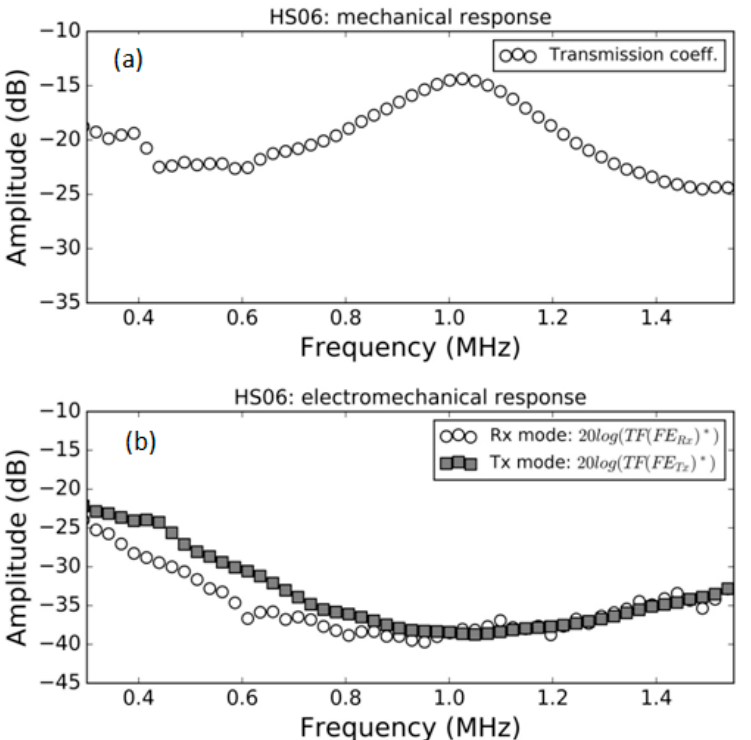
Figure 10. Measured response of the HS06 FE sample in water. ( a ) Modulus of the transmission coefficient vs. frequency; ( b ) electromechanical response vs. frequency both in Tx and Rx mode, (see Equations (16) and (22).